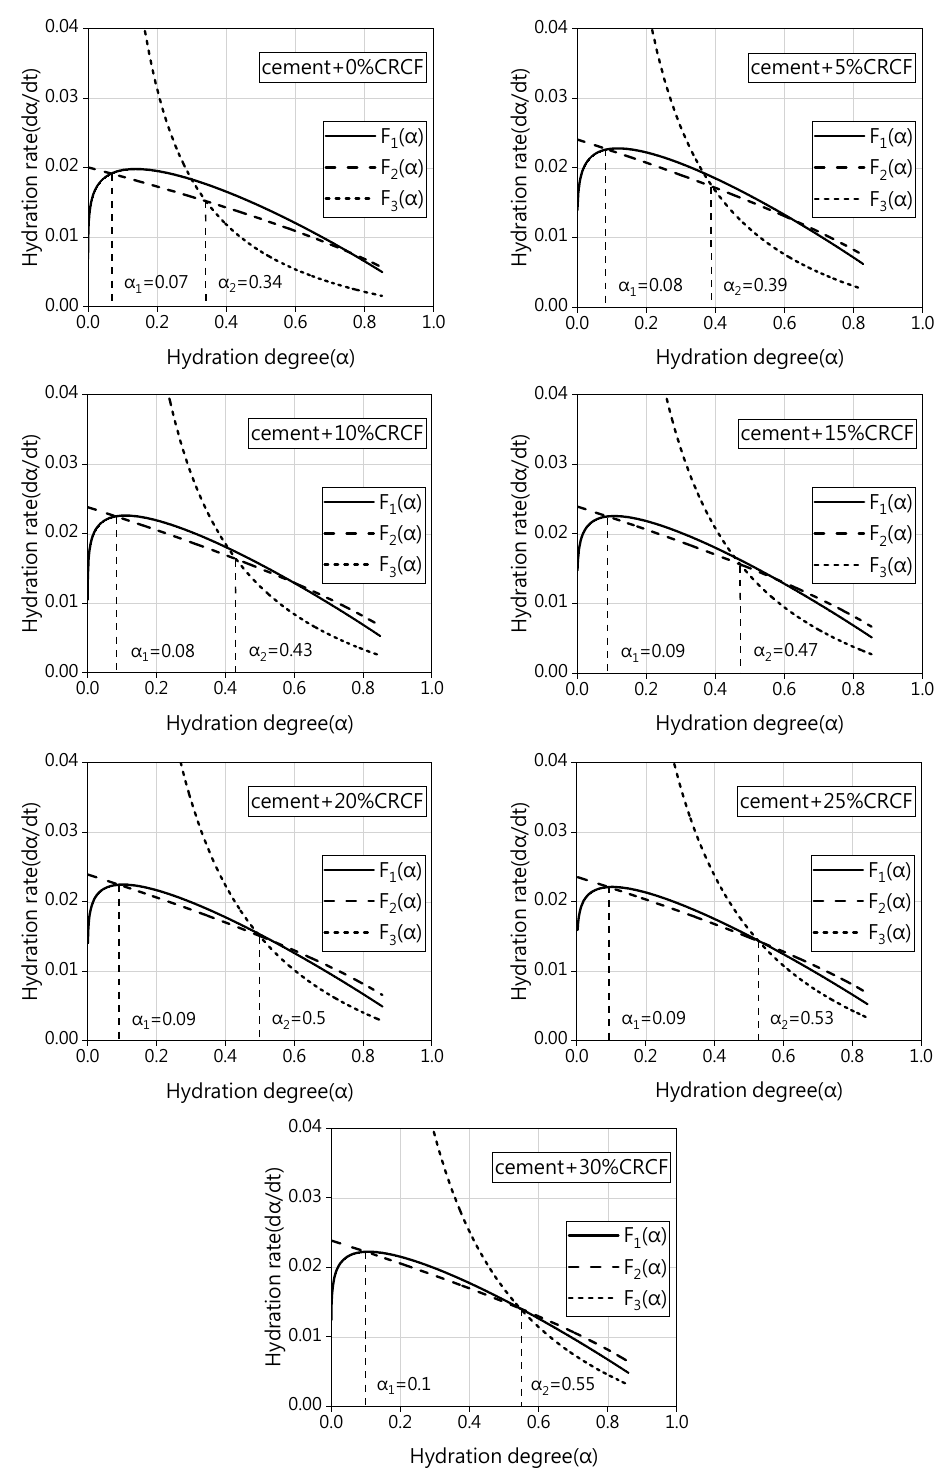
Figure 12. Relationships between hydration degree and hydration rate for paste samples with various CRCF contents.